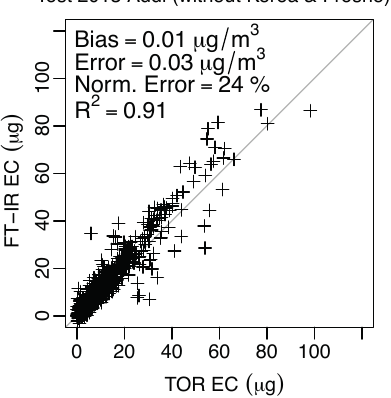
Figure 12. Scatter plot and performance metrics between FT-IR OC and TOR OC for the Test 2013 Addl data sets (Sect. 2.1) without the ambient samples collected at Fresno and Korean sites. Concentra- tion units of µgm − 3 for bias and error are based on the IMPROVE nominal volume of 32.8m 3